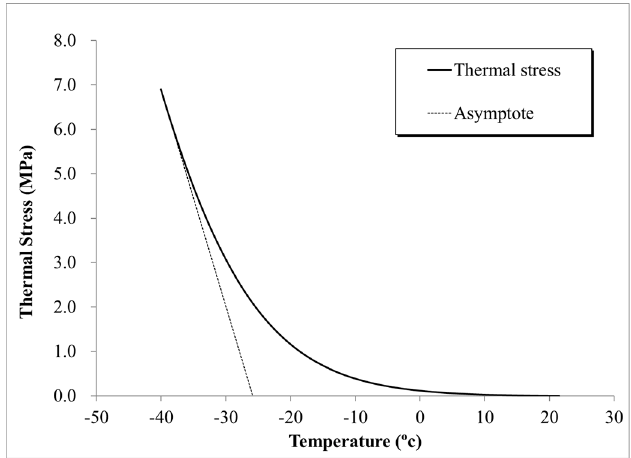
Figure 4. SAP (Single Asymptote Procedure) approach.